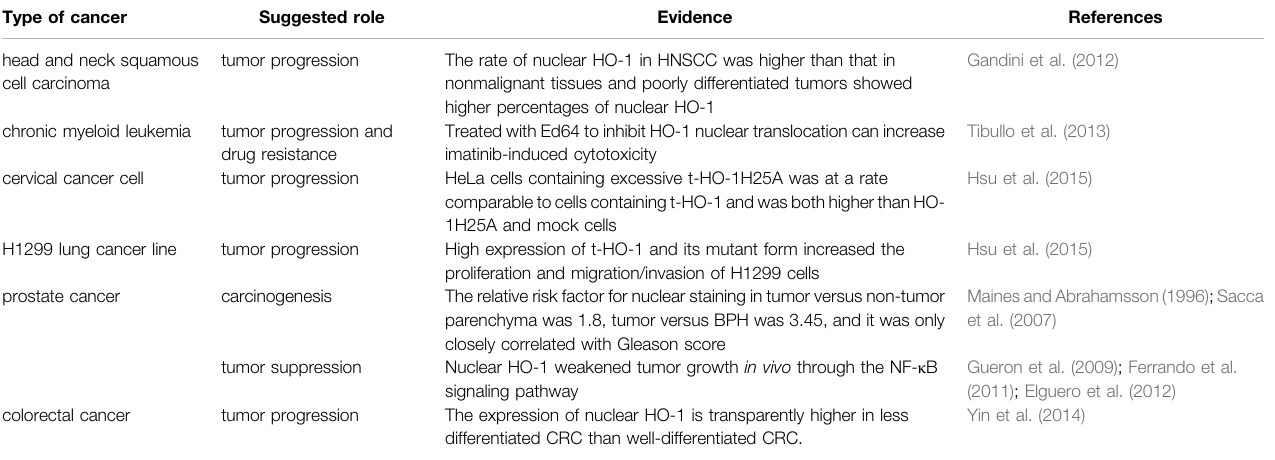
TABLE 1 | Nuclear expression of HO-1 in different cancer